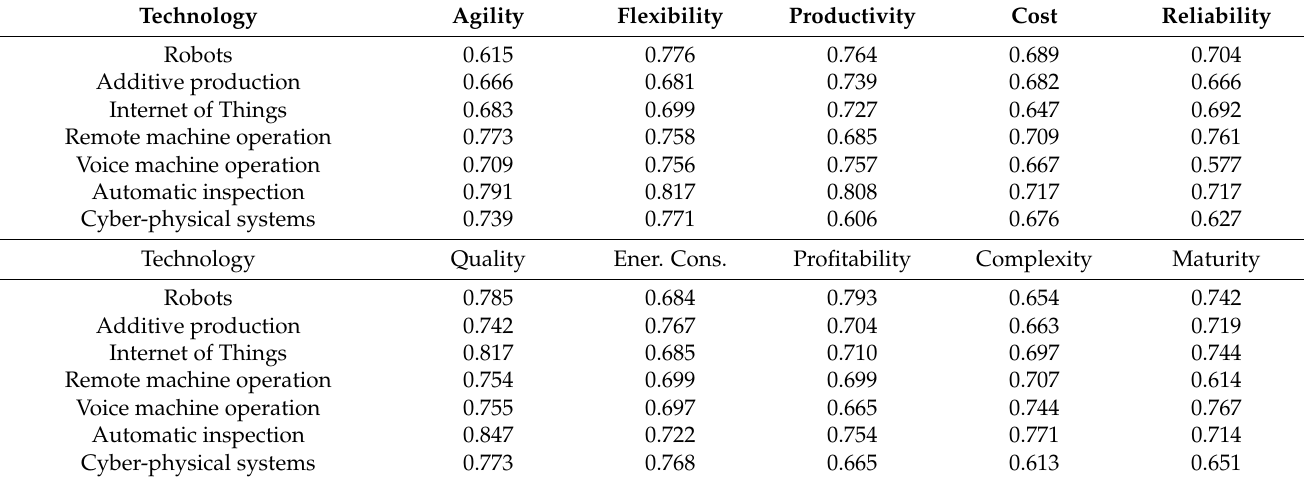
Table A6. The defuzzied weighted geometric sequence.